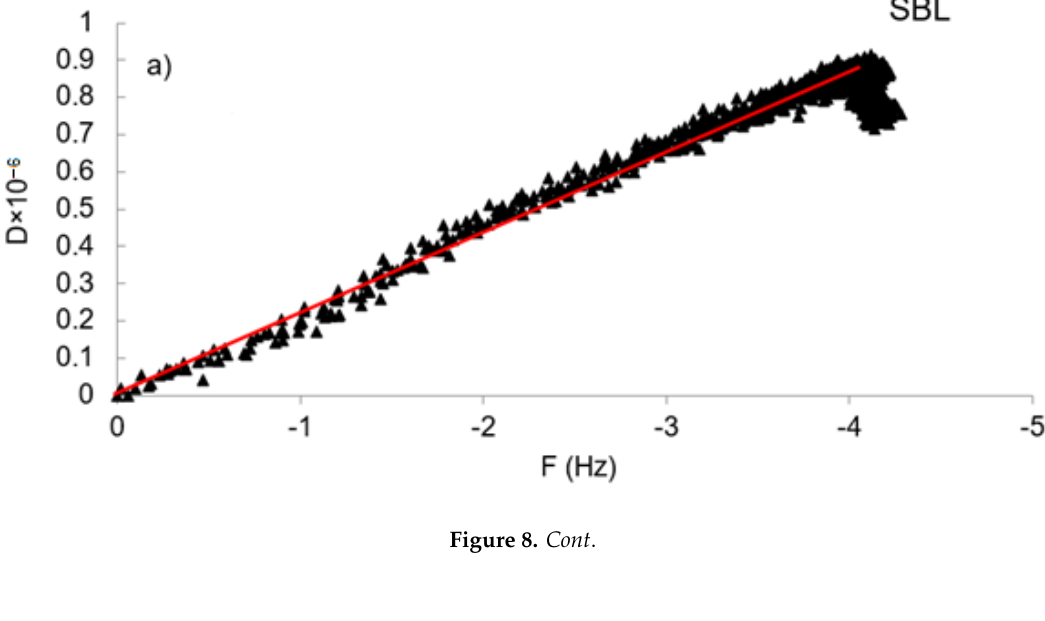
Table 2. Pseudo-first order fitting parameters for the mass uptake of